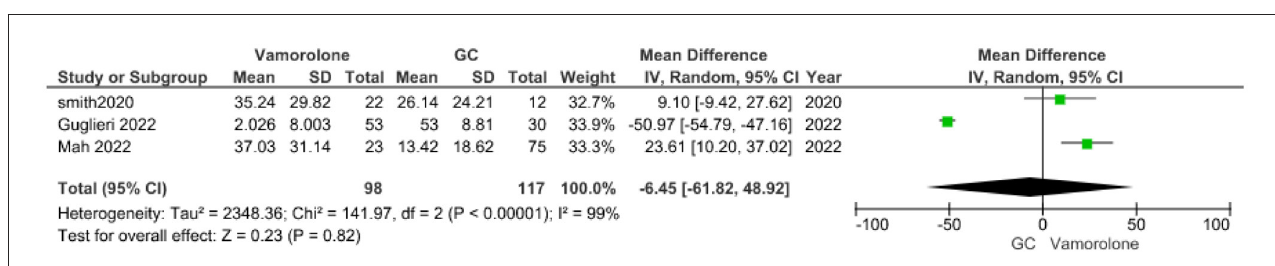
FIGURE8 Height percentile for age outcome vamorolone vs. glucocorticoids.